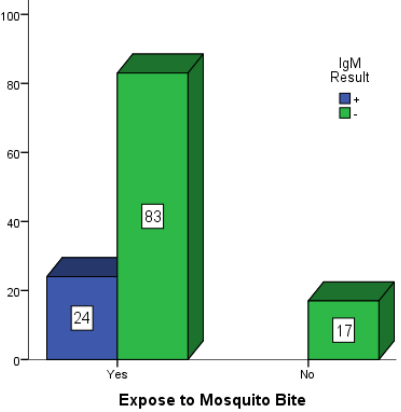
Figure 3. Participants exposed to mosquito bites in Jimeta. Vaccines 2022 , 10 , x FOR PEER REVIEW